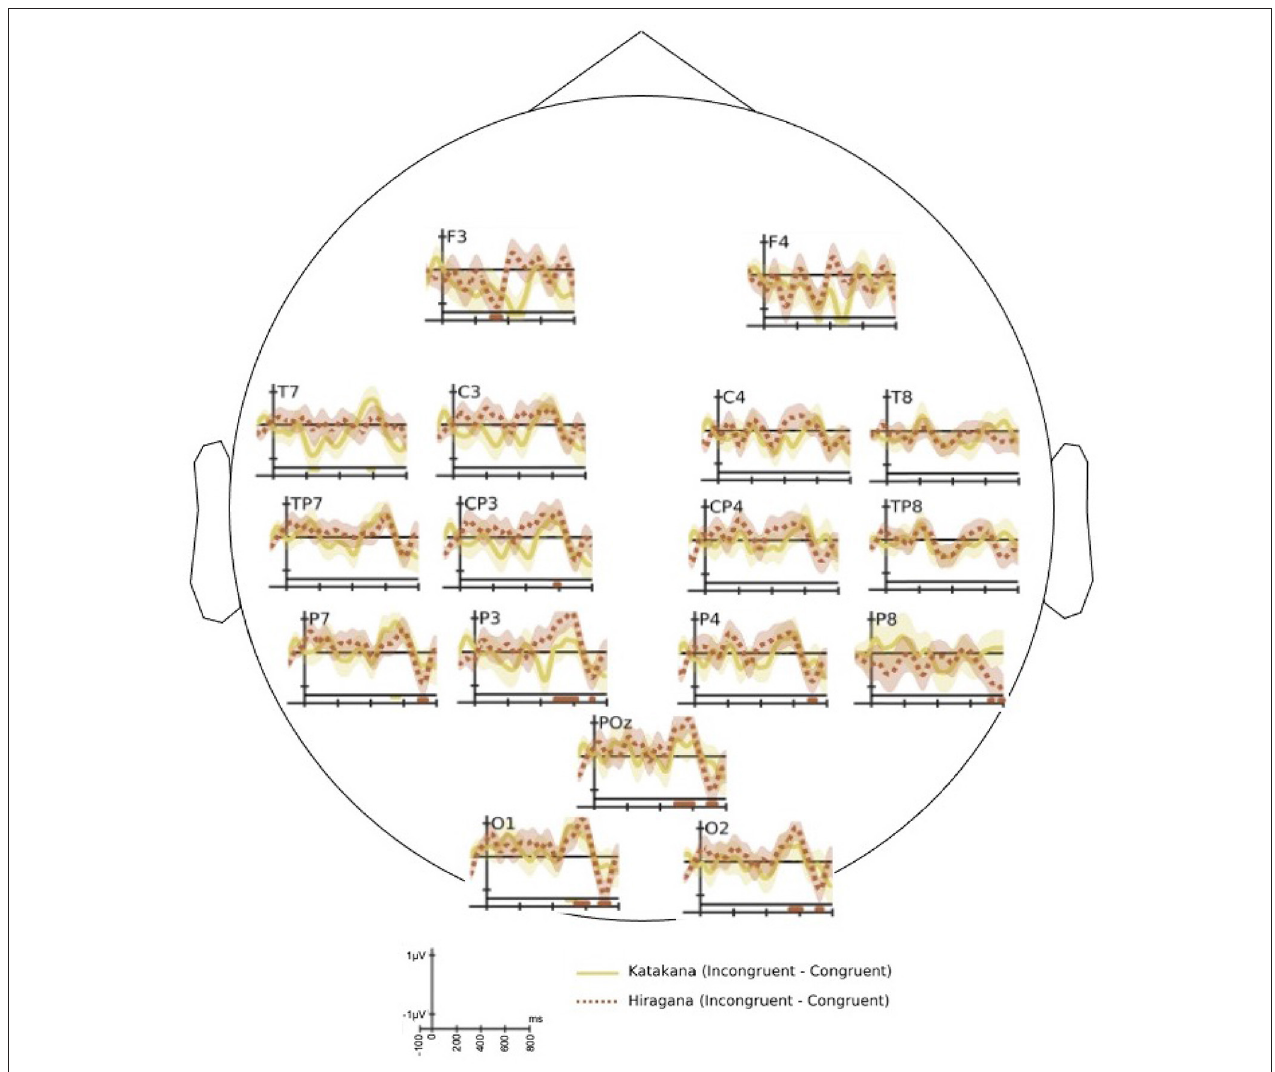
FIGURE 6 | The grand average of difference event-related potential (ERP) of congruent end-word response from in-congruent end-word response for katakana words (solid) and hiragana words (dotted). The horizontal bars drawn in the bottom of each plot signify the time regions with significant (two-sample t -test with p < 0.05) difference in the ERP response. The bars have the same color of the associated difference